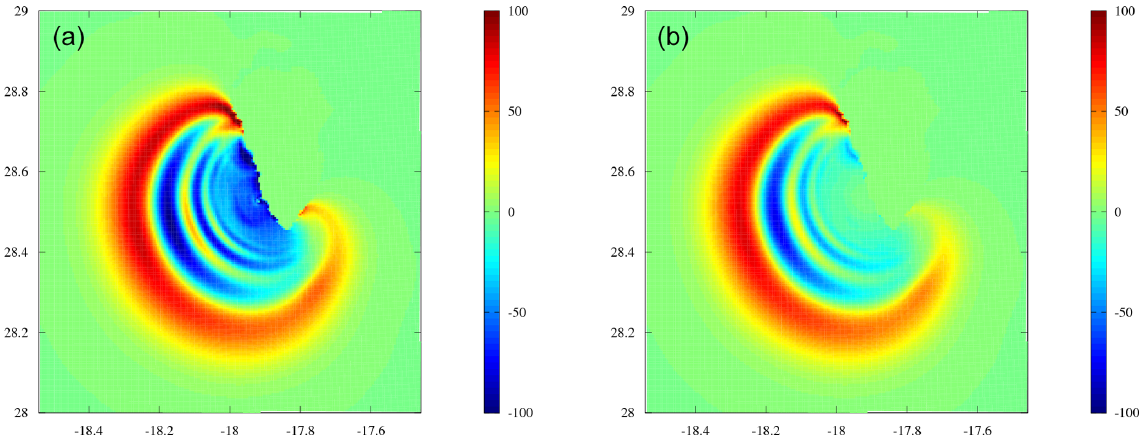
Figure 14. Region around Cumbre Vieja volcano after 5min of simulated time with THETIS for the 80km 3 slide scenario: (a) wave elevation for the initial solution from THETIS and (b) filtered state which is used to initialize